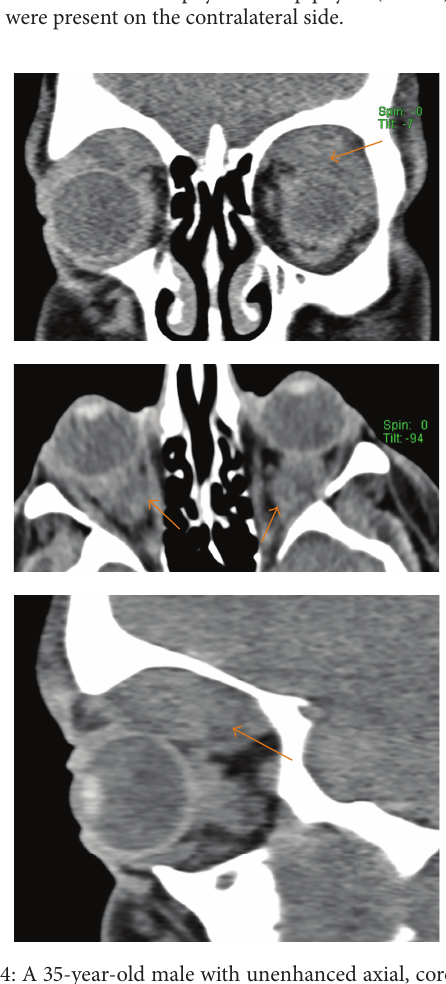
Figure 4: A 35-year-old male with unenhanced axial, coronal, and sagittal reformatted CT images of the orbit: mass-like soft tissue lesions in the intra- and extraconal retrobulbar space (arrow).